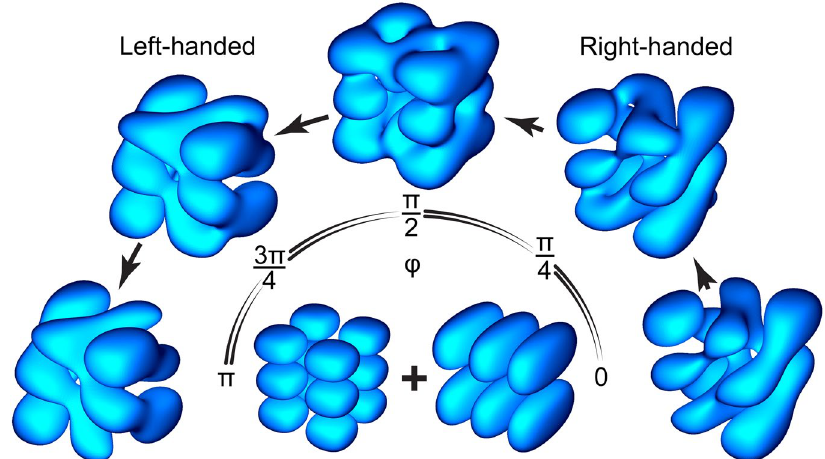
Figure 1. Transformation of probability density | 〈 r| f ( + ) 〉 | 2 with phase ϕ of interaction coupling a pair of resonant nanocuboid states |223 〉 and |312 〉